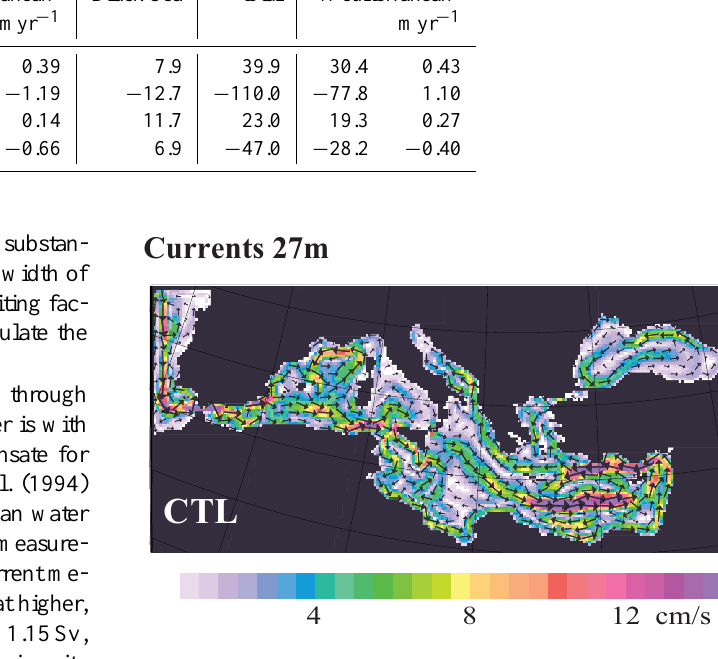
Fig. 5. Currents at 27m depth for CTL. Colours indicate the flow speed in cms − 1 , vectors both direction and speed. Only a subset of vectors has been